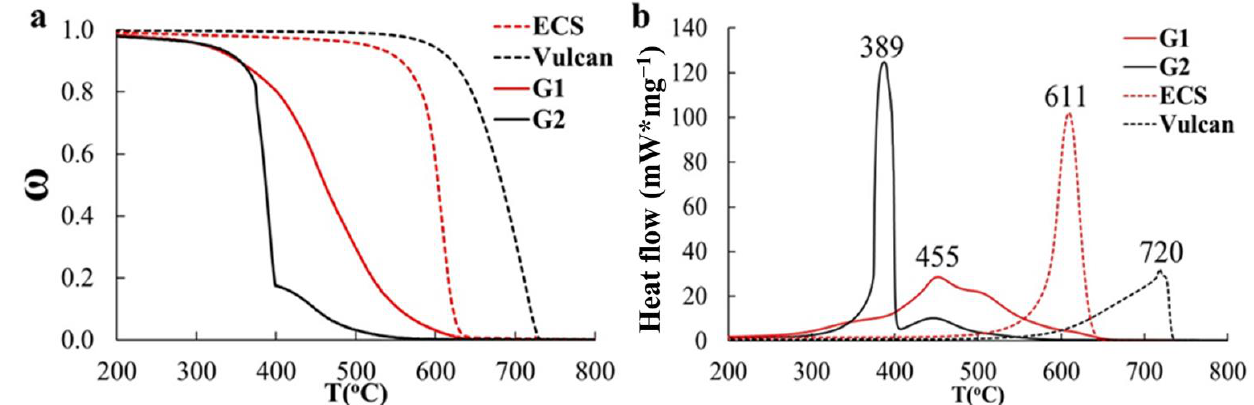
Figure 4. TEM micrographs of Pt/C catalysts: ( a , b ) G1 and ( c , d ) G2, and histograms of the NP size distribution in the corresponding materials.